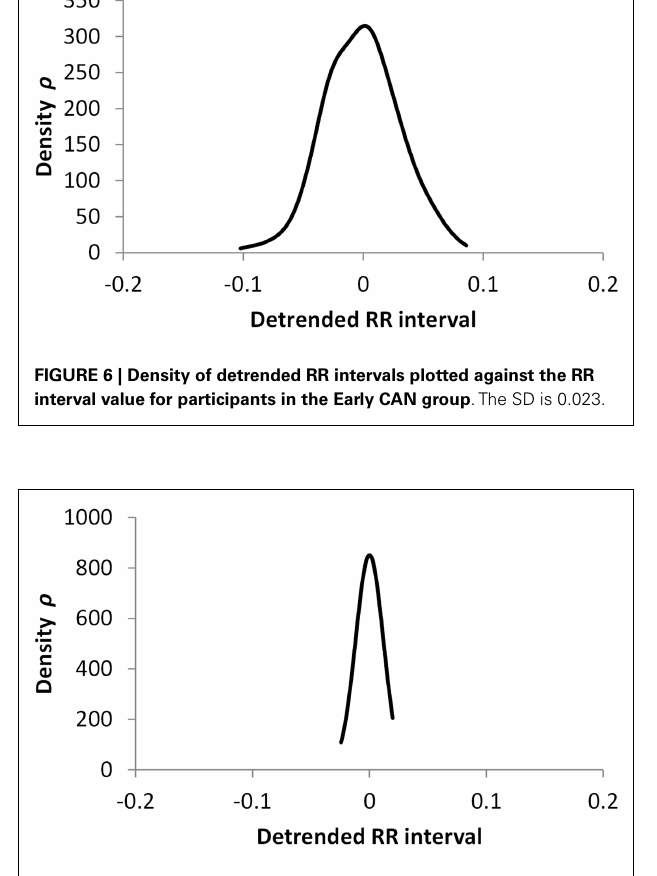
FIGURE 7 | Density of detrended RR intervals plotted against the RR interval value for participants in the Definite CAN group .The SD is